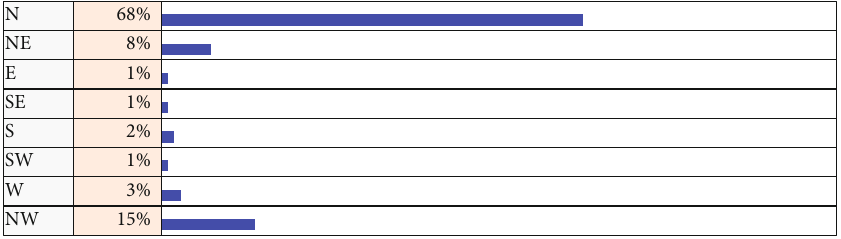
Figure 6: Wind direction (January 2000 – December 2008) at Aswan [21].